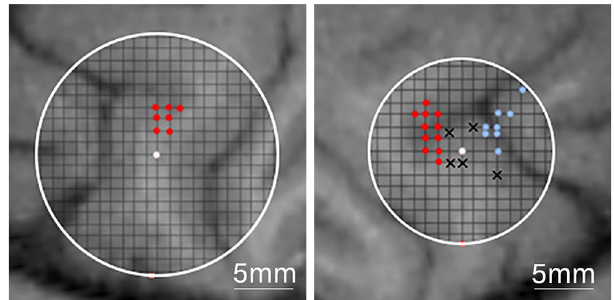
Figure 2. Recording and microstimulation sites. Left PMv (left) and right PMv (right) locations. The center point was denoted as the stereotaxic coordinates used in the craniotomy surgery (15 mm anterior, 23 mm lateral). The size of the perimeter is determined by the chamber used on each side. Inner diameter of the left chamber: 20 mm. Inner diameter of the right chamber: 15 mm. Red dots represent the sites of the cells used in this study. In blue are the sites where a clear eye movement was evoked with microstimulation. Black “x” marks represent sites where no behavior was evoked by electrical